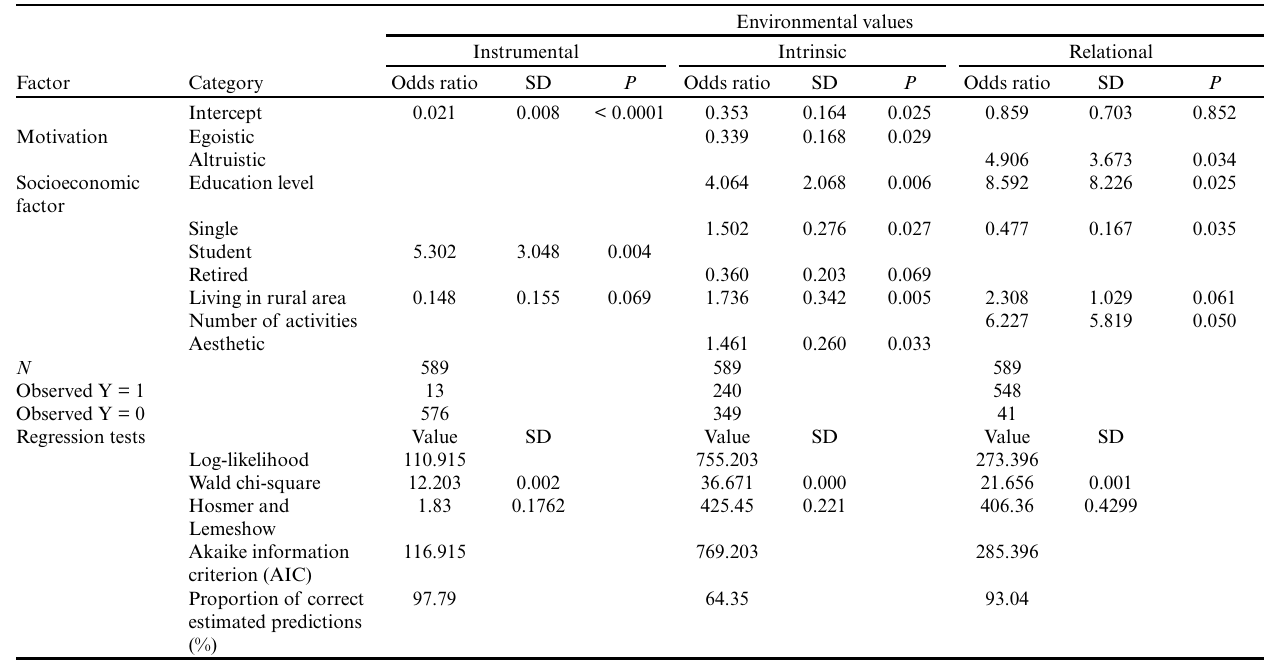
Table 5. Results of logistic regressions that show the effect of motivations and socioeconomic factors on environmental values.